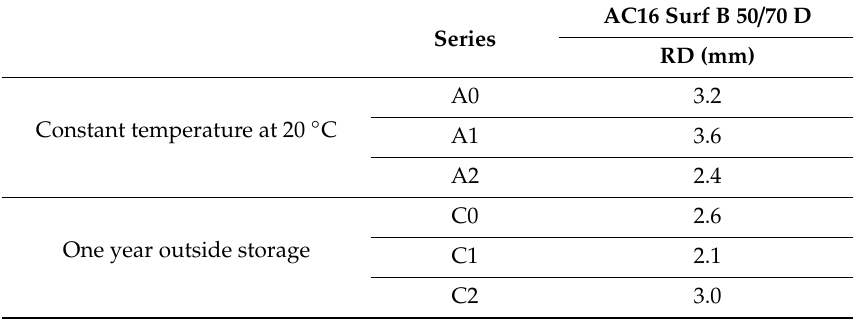
Table 8. Rut depth.